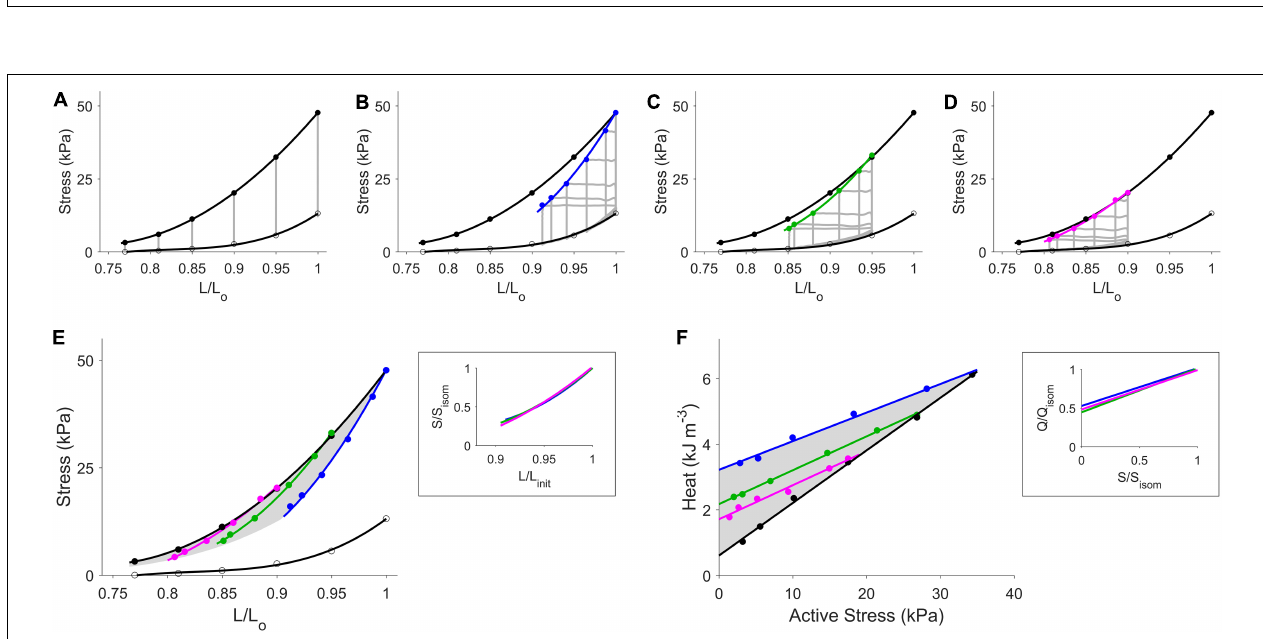
FIGURE 2 | Steady-state data from a representative trabecula superfused with Tyrode solution. In panel (A) , the isometric end-systolic stress-length relation (upper thick line) and the isometric passive stress-length relation (lower thick line) have been fitted to the six isometric contractions (gray lines) at end-systole (black circles) and at end-diastole (open circles), respectively. These two relations have been transcribed to panels (B–E) . The work-loop end-systolic stress-length relation, obtained by fitting to the end-systolic points (filled circles), is dependent on the initial length (lines: blue, green, and magenta, respectively): at L o (B) , 0.95 L o (C) , and 0.90 L o (D) . In panel (E) , all stress-length relations are superimposed, where the shaded area indicates the zone of the end-systolic points as interpolated using the self-normalized work-loop stress-length relations in the inset, in which L init refers to the three initial muscle lengths ( L o , 0.95 L o , and 0.90 L o ). In panel (F) , the shaded area indicates the zone of the heat-stress relations obtained from the three preloaded work-loop contractions and the isometric contractions. The inset shows the three relations between work-loop heat (Q) and stress (S) normalized to their isometric values (subscripted as “isom”).